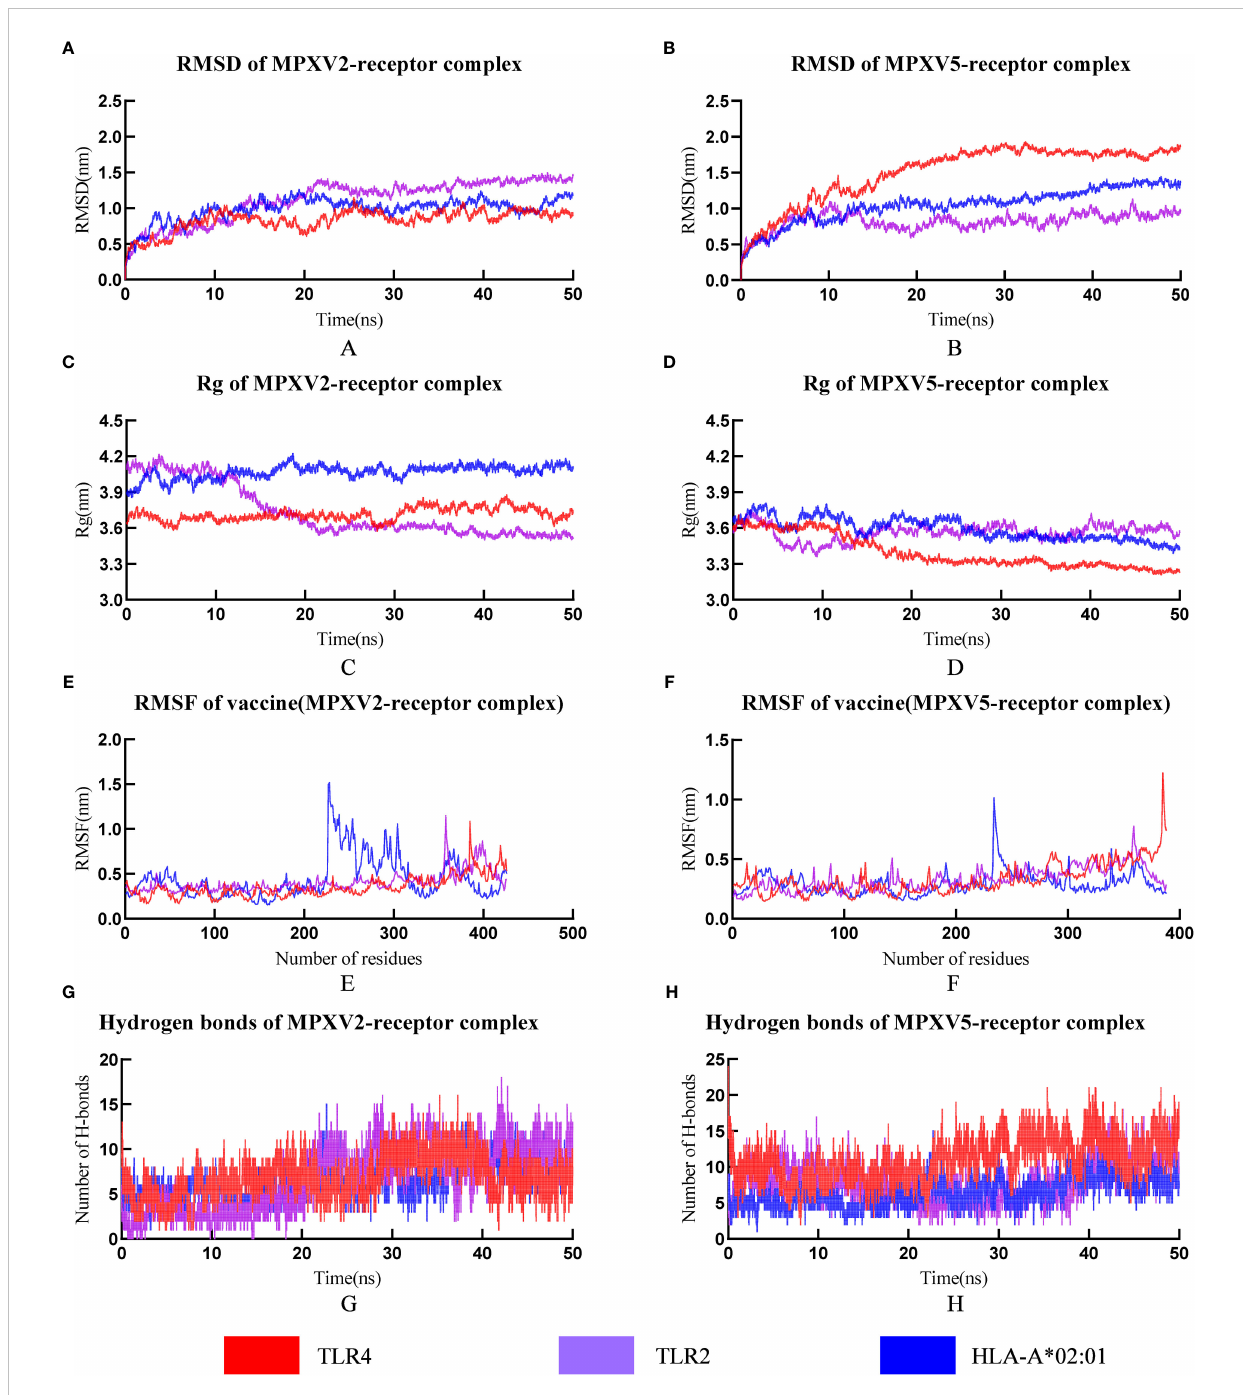
FIGURE 6 The plot of Root means square deviation (RMSD), Root means square fl uctuation (RMSF), Radius of Gyration (Rg) and hydrogen bonds of vaccine- receptor complexes during the Molecular dynamics (MD) simulation. (A) RMSD of MPXV-2-TLR2, MPXV-2-TLR4 and MPXV-2-HLA-A*02:01 complexes; (B) RMSD of MPXV-5-TLR2, MPXV-5-TLR4 and MPXV-5-HLA-A*02:01 complexes; (C) Rg of MPXV-2-TLR2, MPXV-2-TLR4 and MPXV-2- HLA-A*02:01 complexes; (D) Rg of MPXV-5-TLR2, MPXV-5-TLR4 and MPXV-5-HLA-A*02:01 complexes; (E) RMSF of MPXV-2 chain in MPXV-5- TLR2, MPXV-5-TLR4 and MPXV-5-HLA-A*02:01 complexes; (F) RMSF of MPXV-5 chain in MPXV-5-TLR2, MPXV-5-TLR4 and MPXV-5-HLA-A*02:01; (G) Hydrogen bonds in MPXV-2-TLR2, MPXV-2-TLR4 and MPXV-2-HLA-A*02:01 complexes; (H) Hydrogen bonds in MPXV-5-TLR2, MPXV-5-TLR4 and MPXV-5-HLA-A*02:01